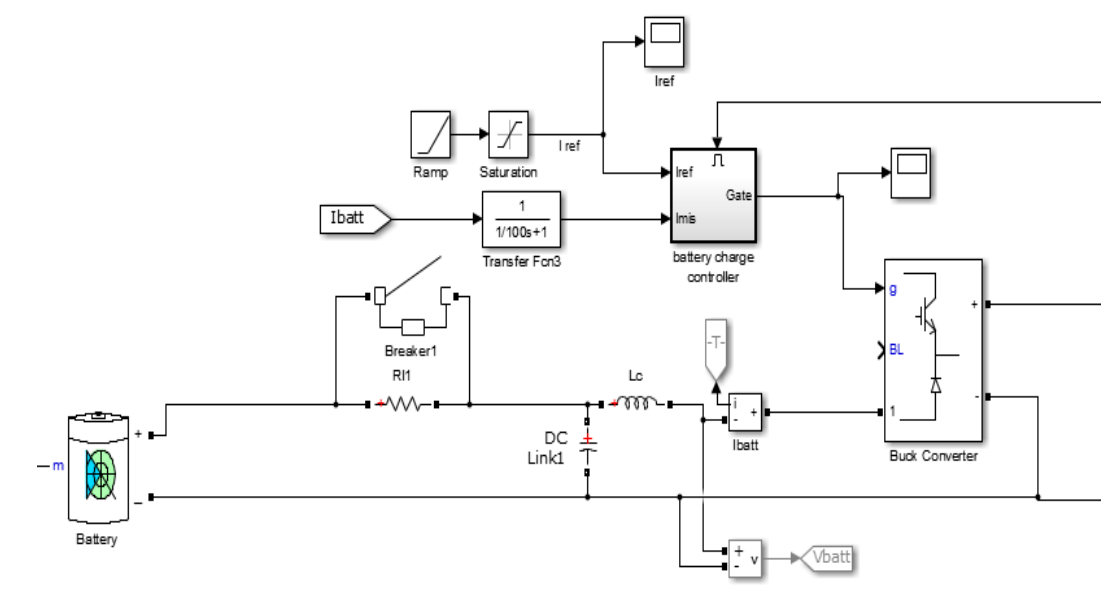
Figure 6. Model of the car battery and the converter.